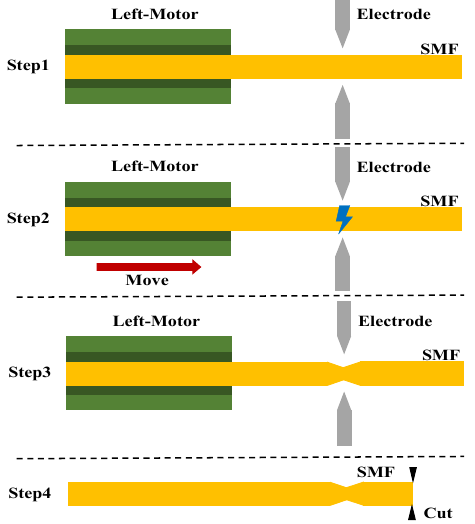
Figure 2. Schematic diagram of the sensor fabrication method.